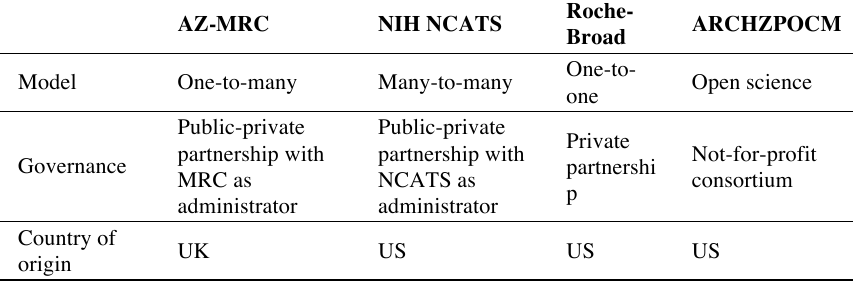
Fig. 1. Alternate structures of initiatives to recover abandoned compounds Table 2. Description of recent initiatives to recover abandoned